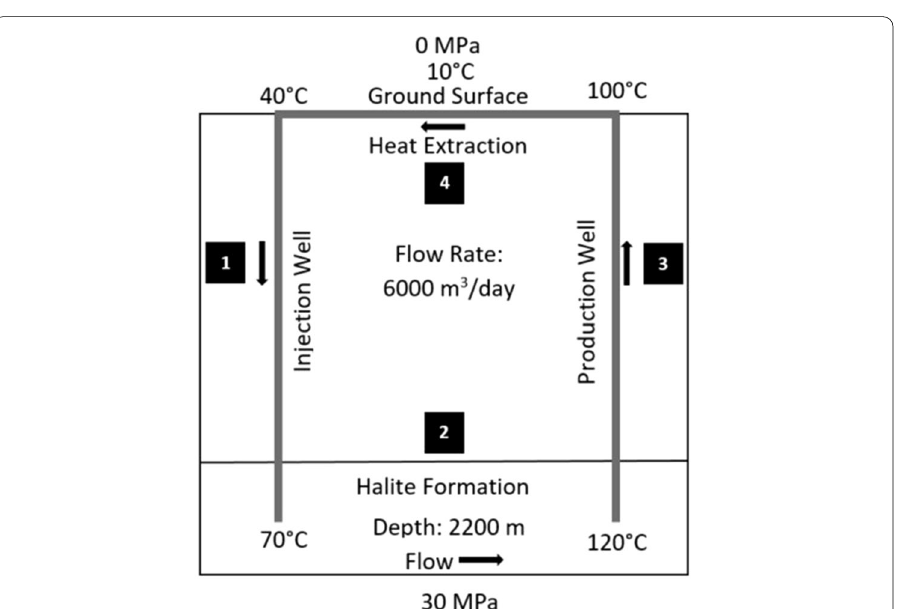
Fig. 1 Conceptual model with injection well, halite reservoir, production well, and surface conditions. Shown are the temperature conditions and flow rates. Also shown are the 4 intervals discussed in "Batch reaction calculations"